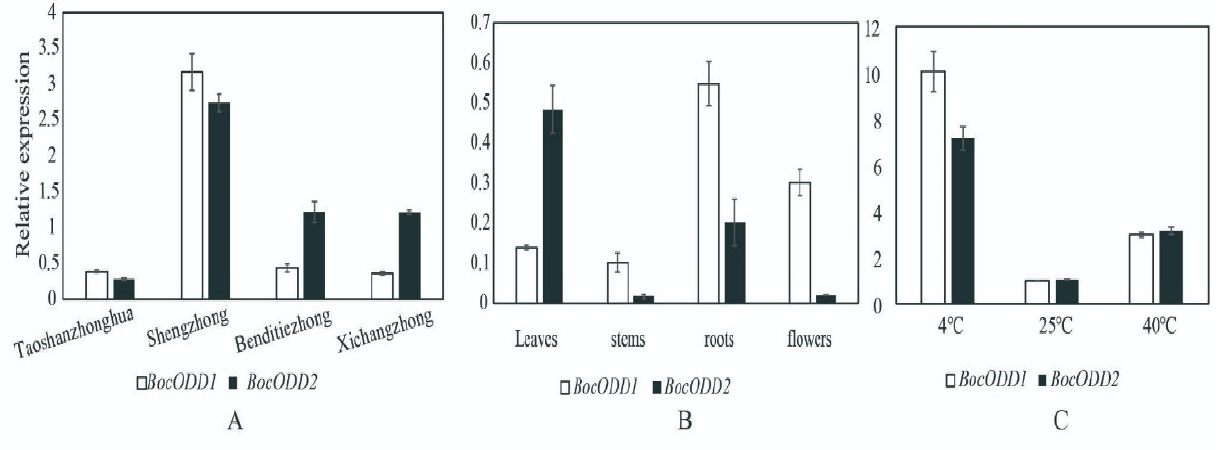
Figure 6. Expression analysis of BocODD1/2 in Chinese kale. ( A ) the expression levels of BocODD1 and BocODD2 in four genotypes—Shengzhong, Taoshanzhonghua, Benditiezhong, and Xichangzhong; ( B ) the expression levels of BocODD1 and BocODD2 in leaves, stems, roots, and flowers; ( C ) the expression levels of BocODD1 and BocODD2 in leaves treated for 4 h at 4 ◦ C, 25 ◦ C, and 40 ◦ C.